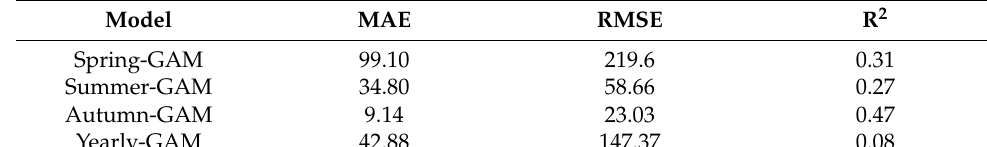
Table 3. Results of cross-validation.